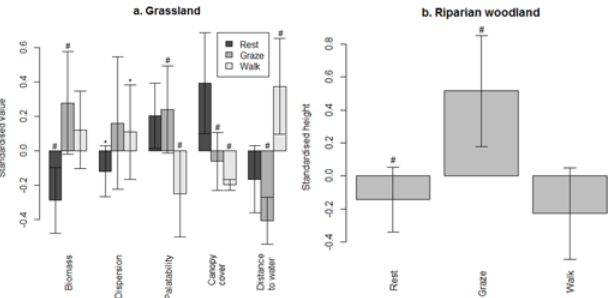
other, respectively.